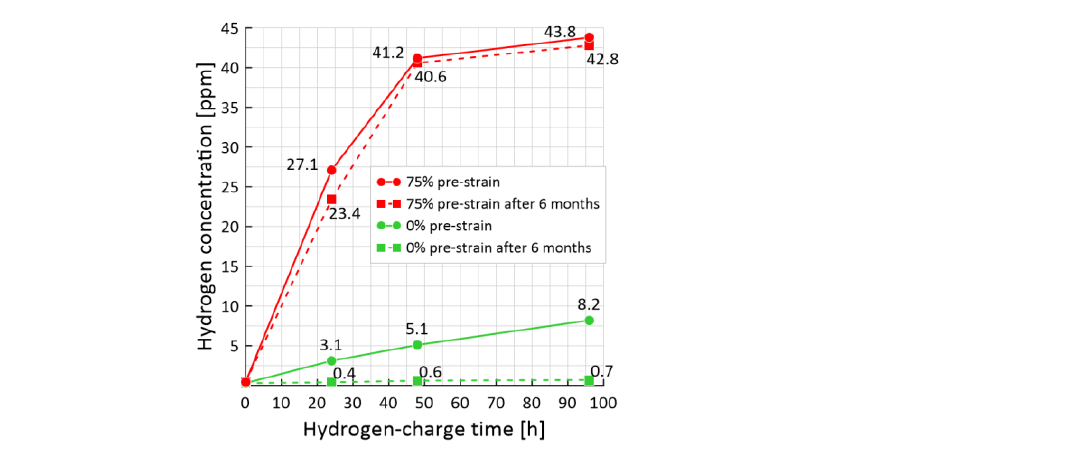
Figure 8. The effect of pre-strain on the hydrogen concentration measured immediately after the experiment in different parts of the sample.